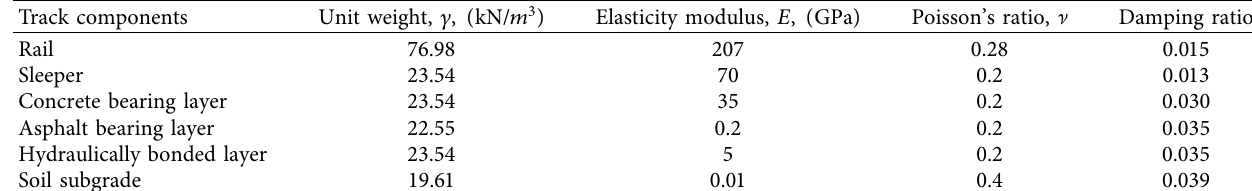
Table 2: Mechanical properties of Shinkansen track components